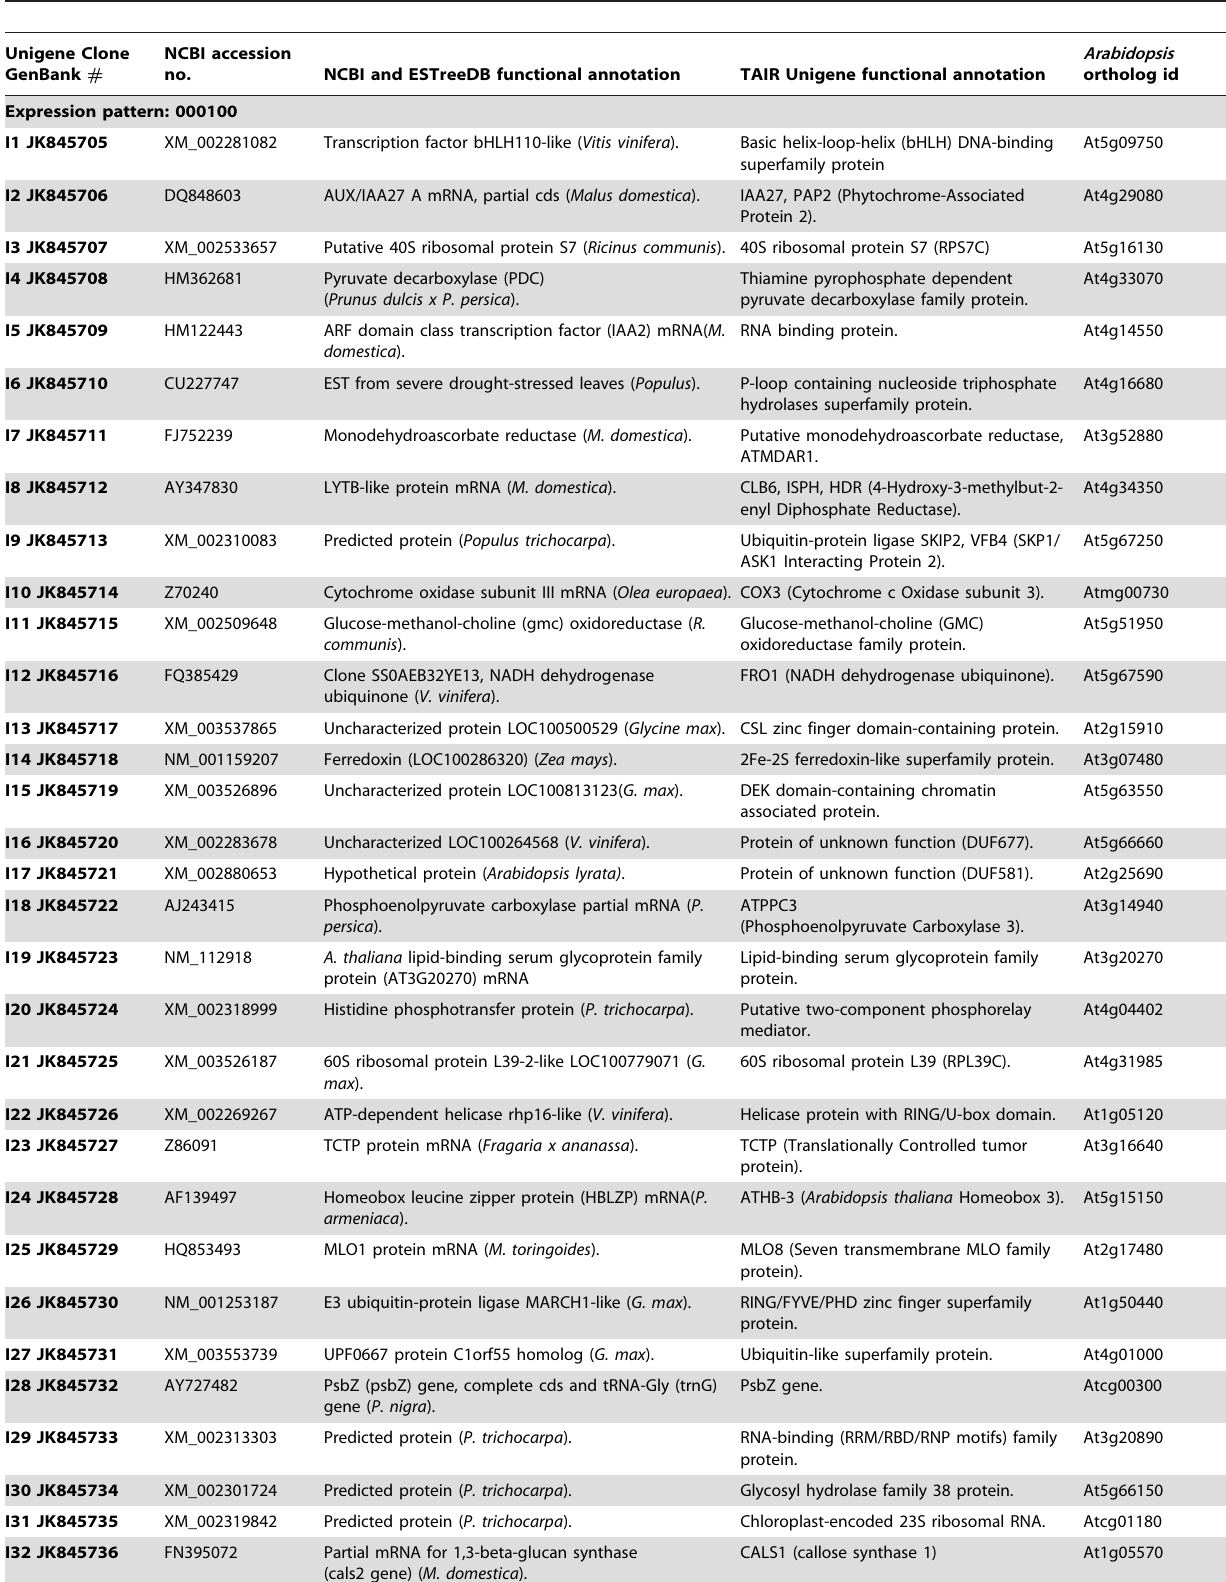
Table 2. Functional identity and gene ontology description of the isolated unigenes corresponding to the ‘‘Induced Group’’ (IG)